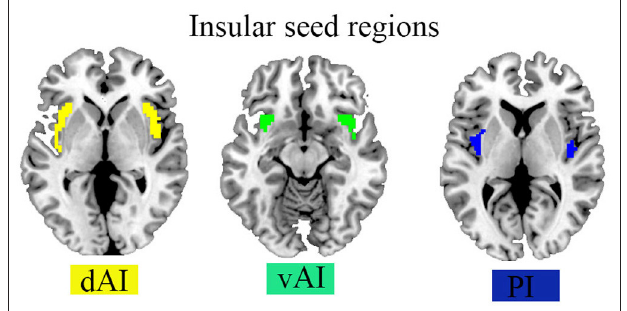
FIGURE 1 | Seed regions of the insula in the Brian.